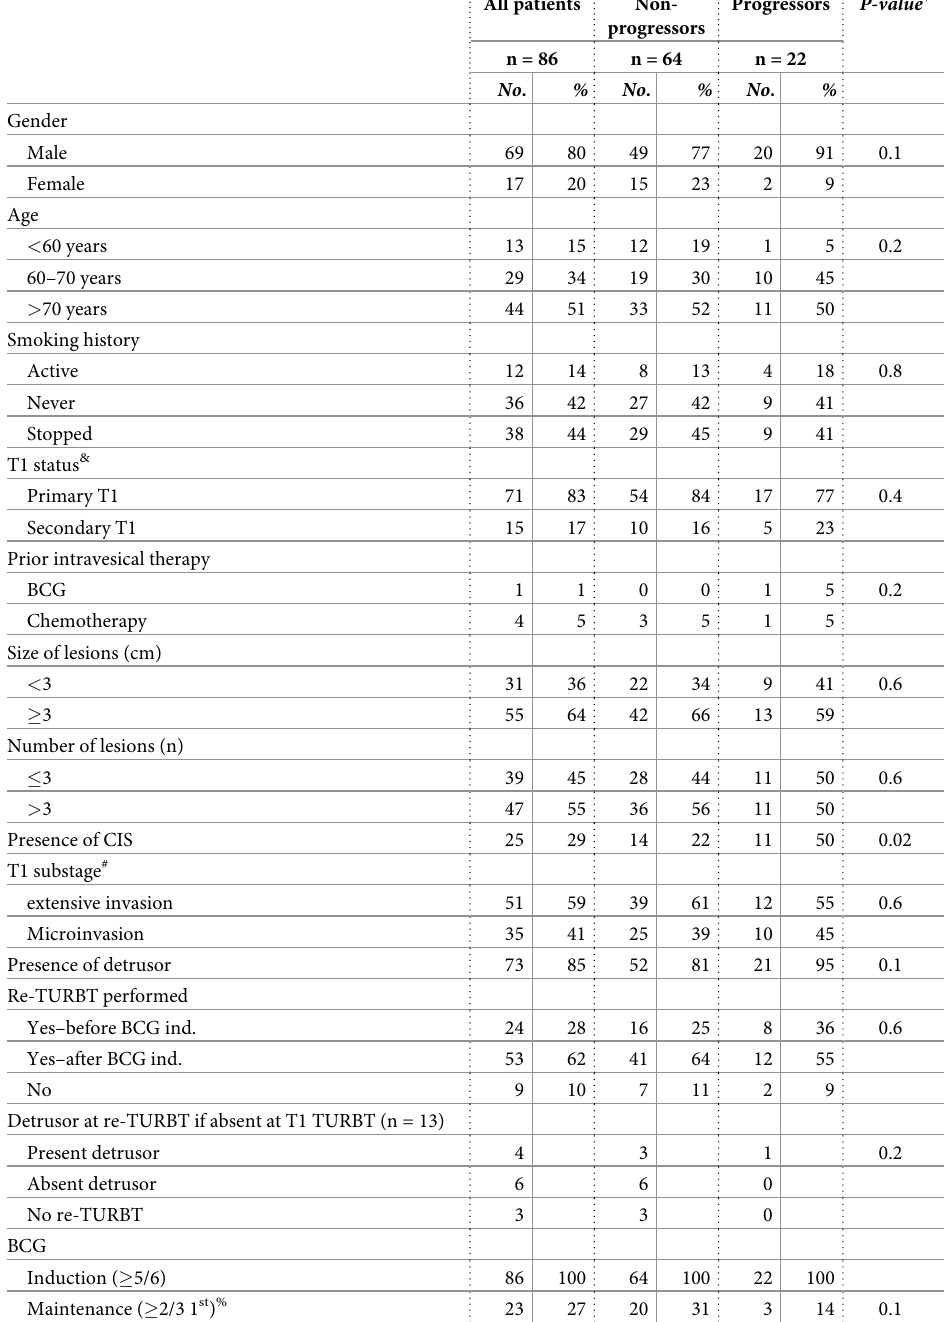
Table 1. Clinical and pathological characteristics of included